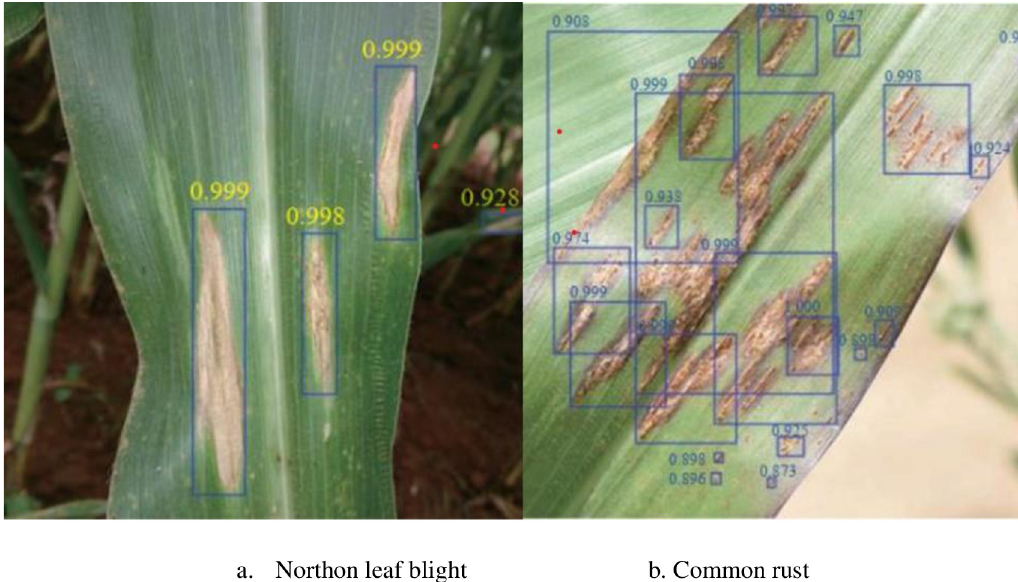
Fig 8. Example of recognition results of northern leaf blight and common rust. a. Northon leaf blight. b. Common rust.